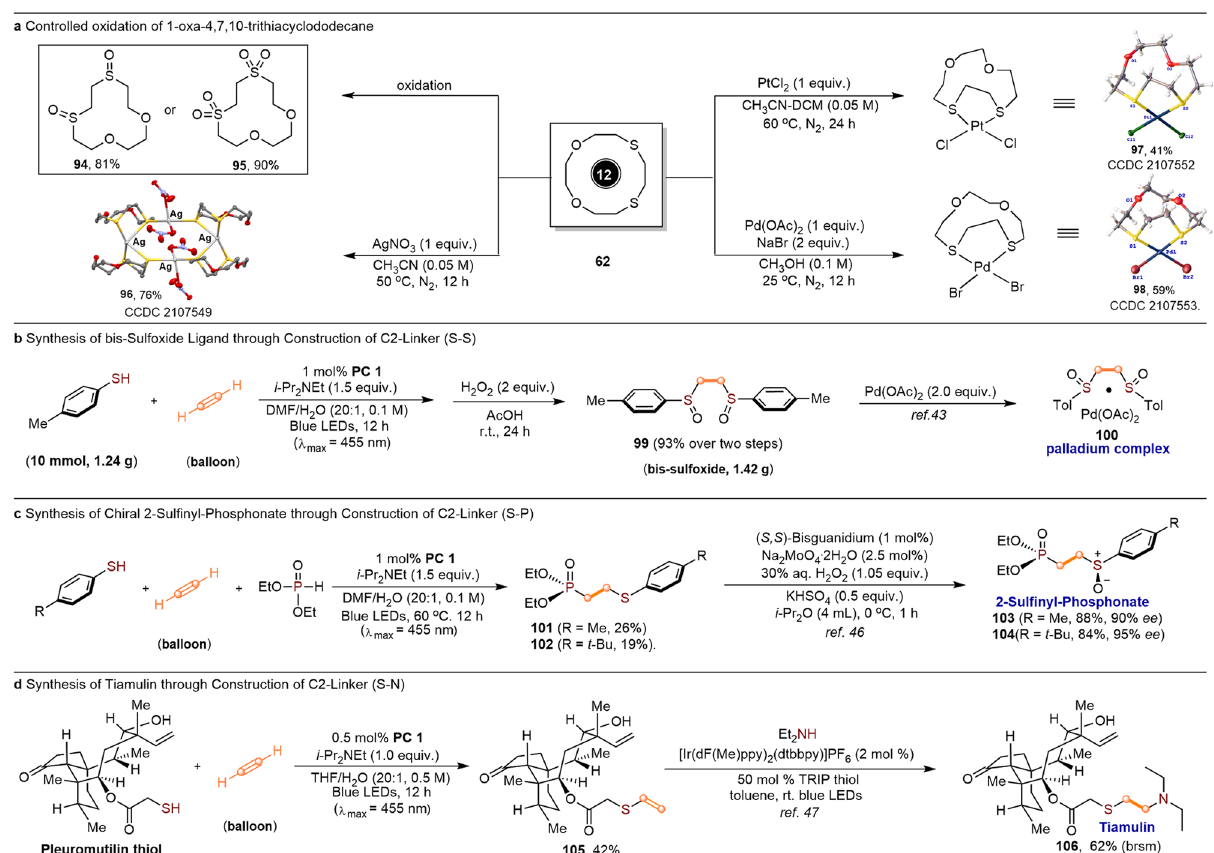
Fig. 5 | Applications. a Controlled oxidation of 1-oxa-4,7,10-trithiacyclododecane. b Synthesis of bis-sulfoxide ligand. c Synthesis of chiral 2-sul fi nyl-phosphonate. d Synthesis of